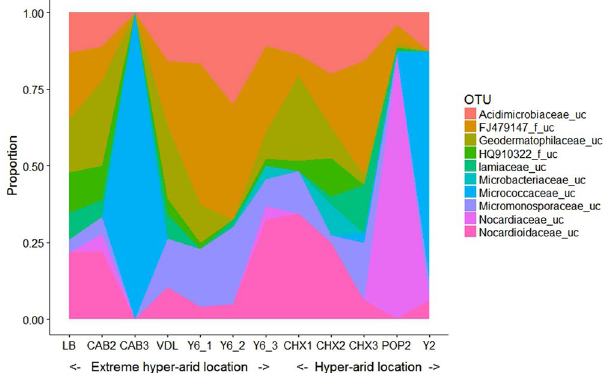
Figure 4. Relative abundance of top 10 most frequently detected actinobacterial families in Atacama Desert locations.